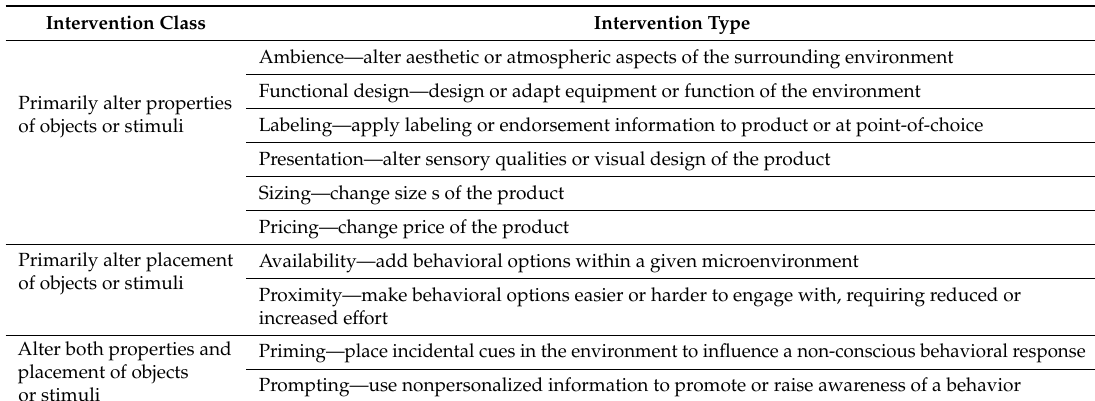
Table 2. Nudging and choice architecture typology from Al-Khudairy et al., 2019 [22] and Hollands et al., 2013